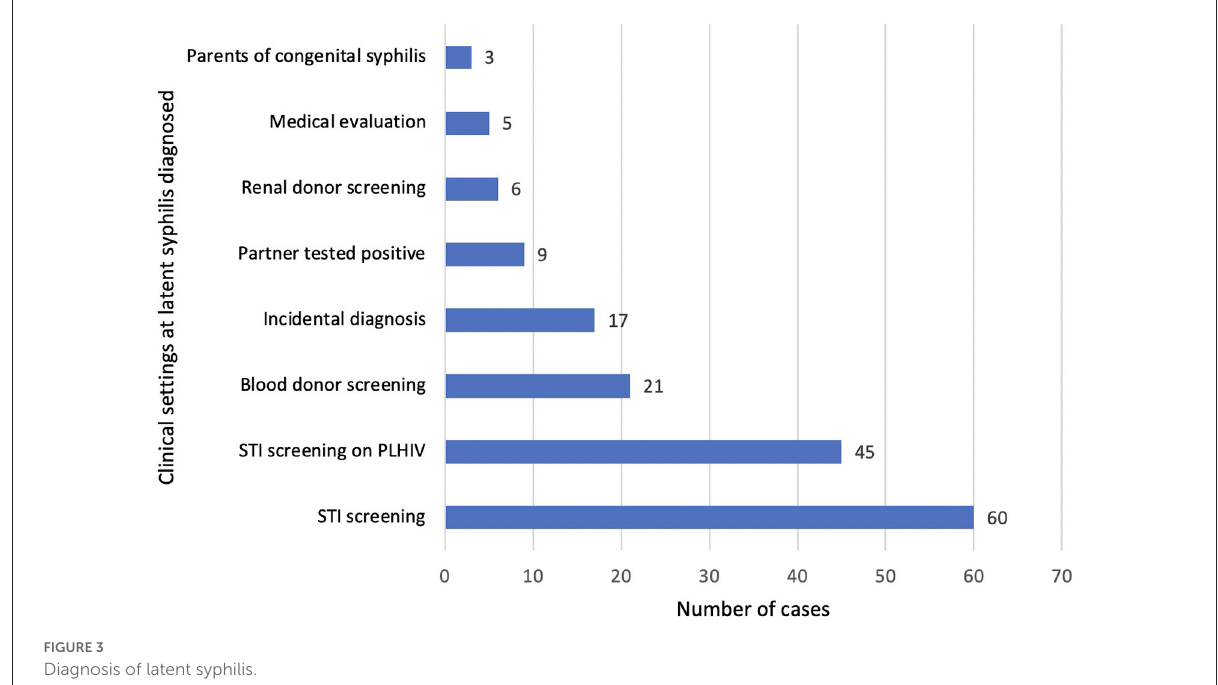
FIGURE3 Diagnosis of latent syphilis.